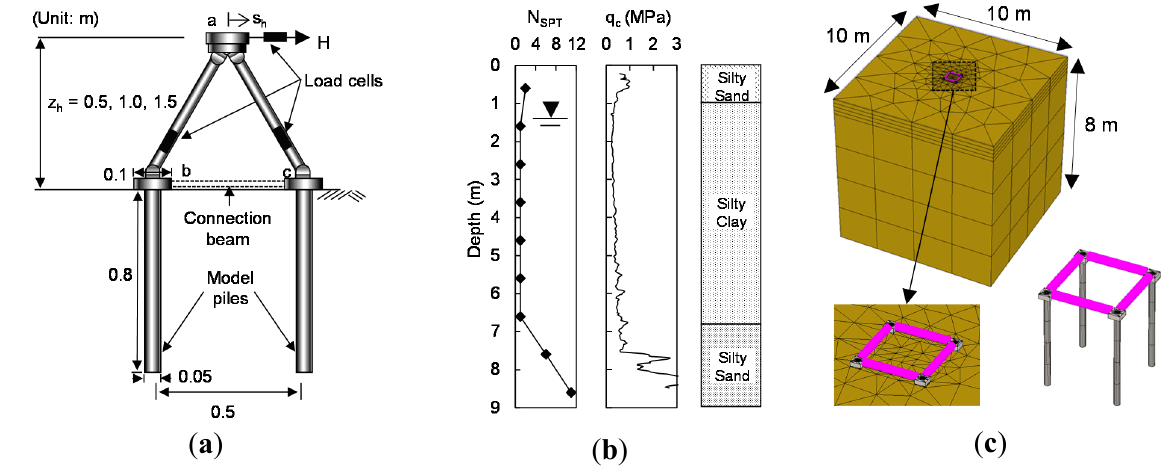
Figure 6. Small-scale model load tests with connected foundations [22]: ( a ) model structures; ( b ) depth profiles of soil layer, SPT, and CPT results; and ( c ) FE model